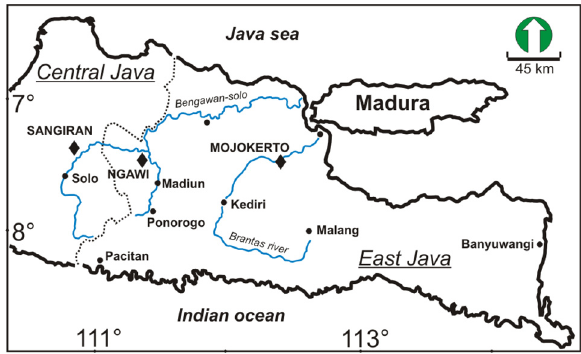
Figure 2. Key sites discussed in the text. The main localities under study are in Central and East Java, namely Sangiran, Ngawi, and